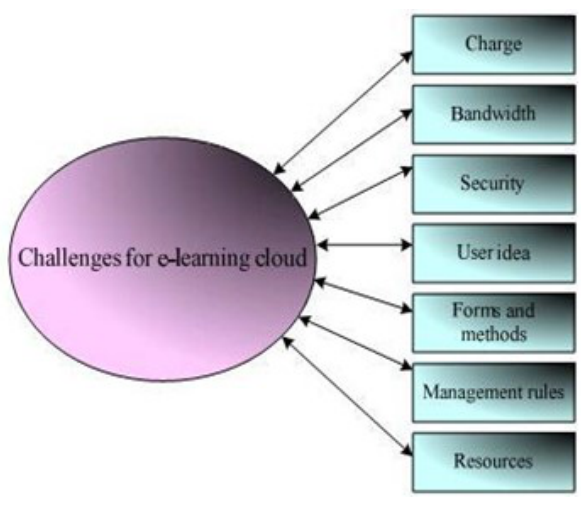
Figure 7. Challenges for E-Learning Cloud [48]